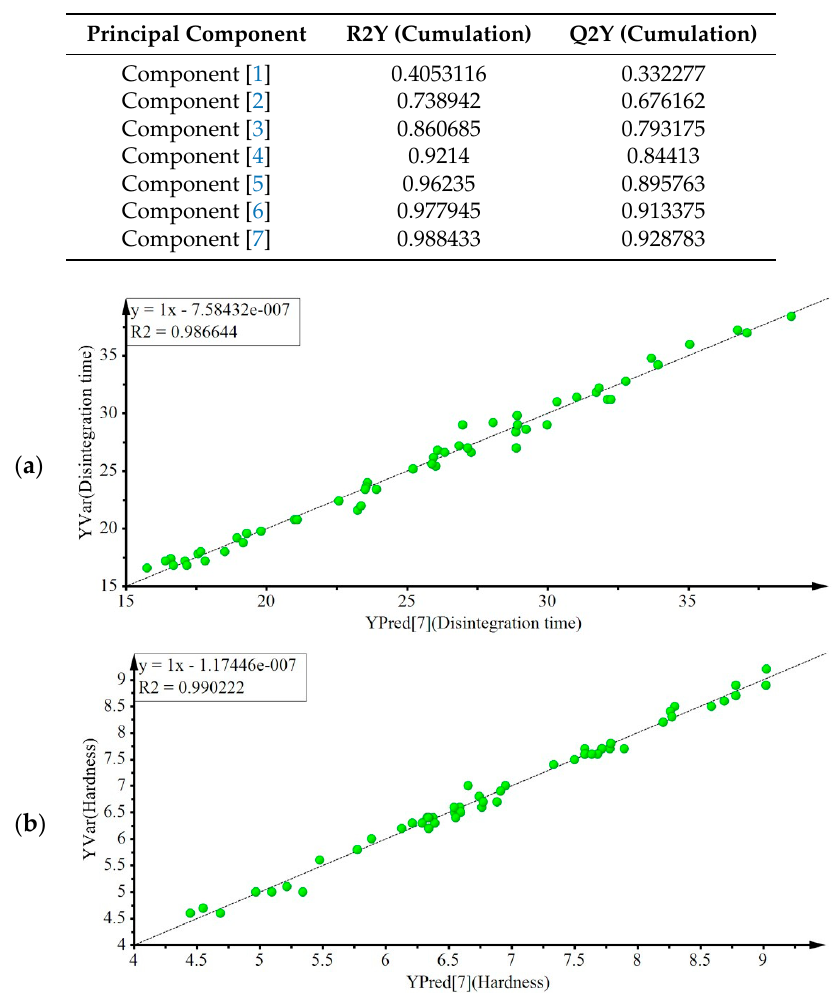
Table 9. The diagnostics for partial least squares (PLS) regression model.